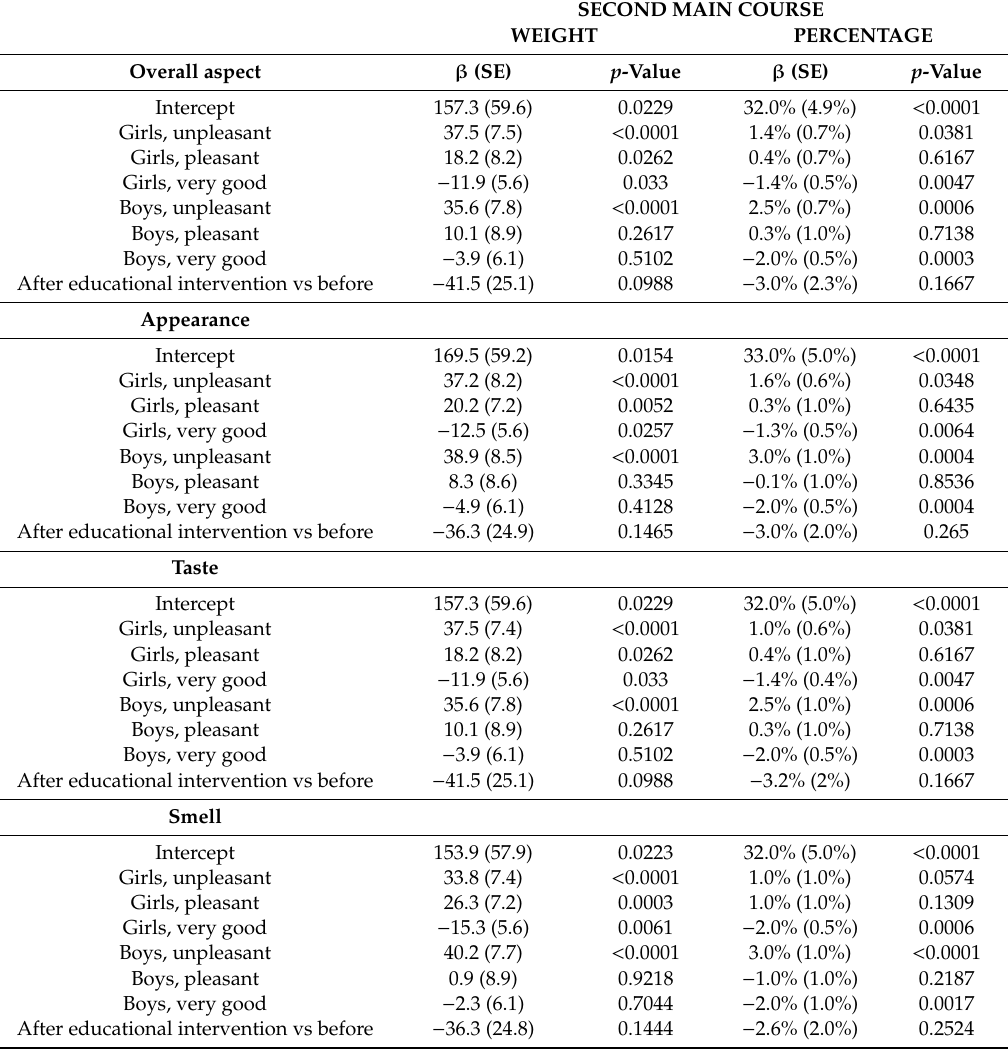
Table 6. Regression coe ffi cients of the model for evaluating waste weight and percentage from the second course for the numbers of boys and girls expressing pleasant, indi ff erent or unpleasant judgments on overall aspect, appearance, smell and